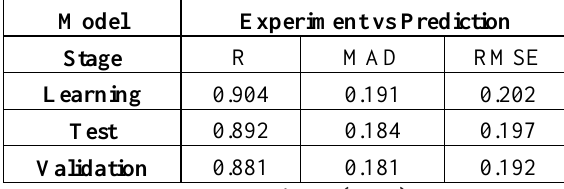
Table 4: Proposed GEP model performance in different stages.